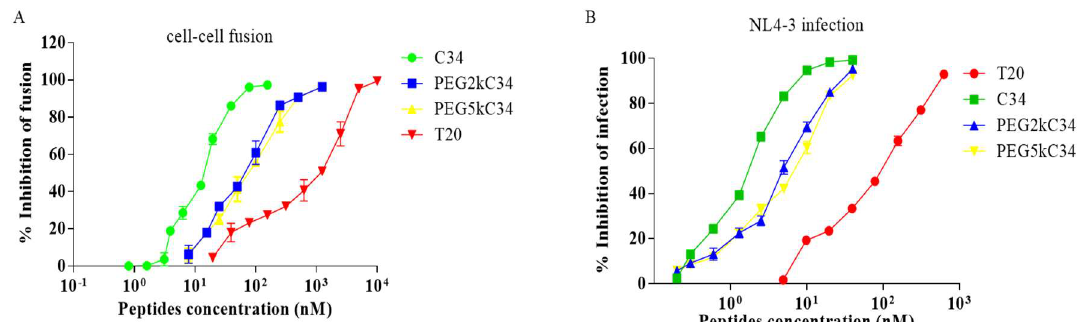
Figure 3. The inhibitory activities of the peptides. ( A ) The inhibitory activities of T20, C34, PEG2kC34 and PEG5kC34 against cell–cell fusion. ( B ) The infection inhibitory activities of T20, C34, PEG2kC34 and PEG5kC34 against the laboratory-adapted strain NL4-3 in TZM-bl cells.